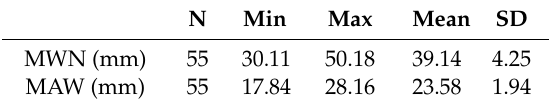
Table 1. Descriptive statistics of the maximum width of the nose (MWN) and the maximum width of the nasal aperture (MAW).